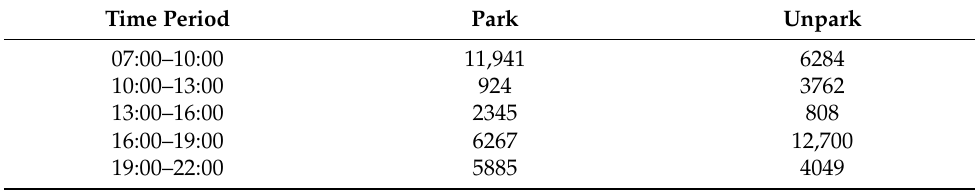
Table 7. Park and Unpark actions.